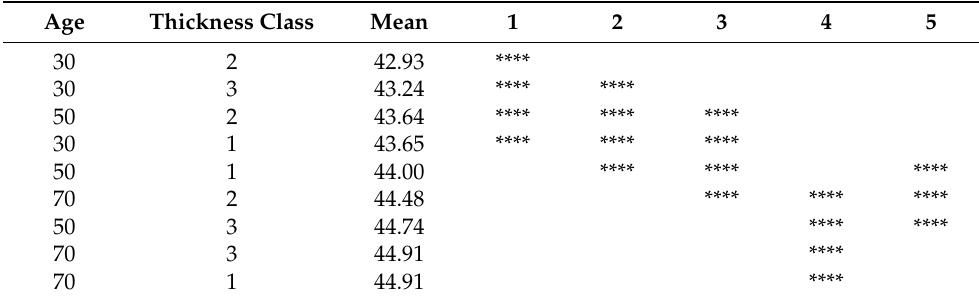
Table 10. Homogeneous groups in terms of mean wood hardness values for tree age and thickness class (HSD Tukey’s range test).